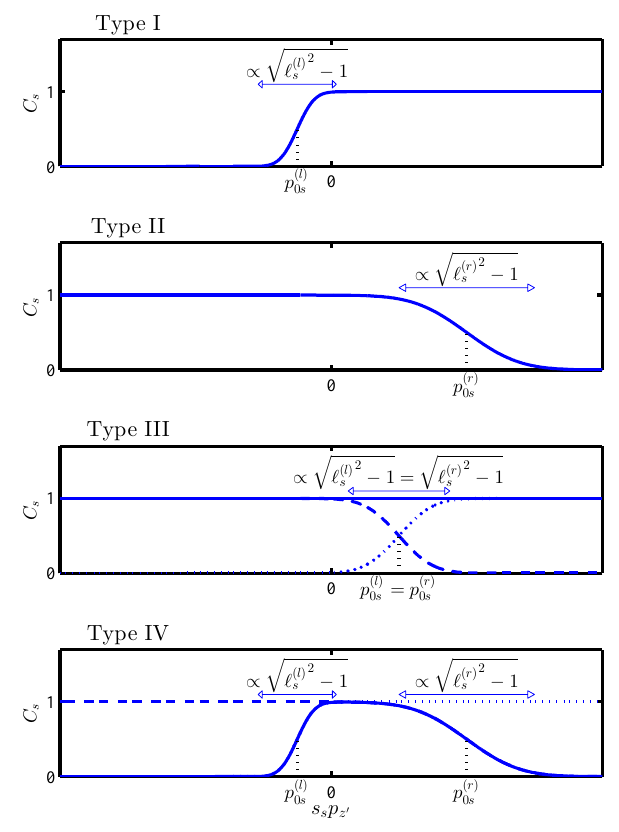
Fig. 3. Four types of cutoff functions are considered: Type I and II produce populations that are constrained to one side of the transi- tion; Type III corresponds to Maxwellian distributions, and Type IV is a two-sided cutoff function. Note that s s p z 0 ∼ | Z | eA z 0 corre- sponds to +∞ if x → −∞ and to −∞ if x → +∞ . Z s eQ ( 001 ) s are expressed in terms of the potentials φ and A